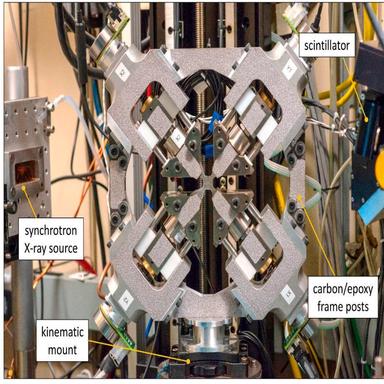
The in-situ biaxial load frame installed at the ALS beamline 8.3.2.